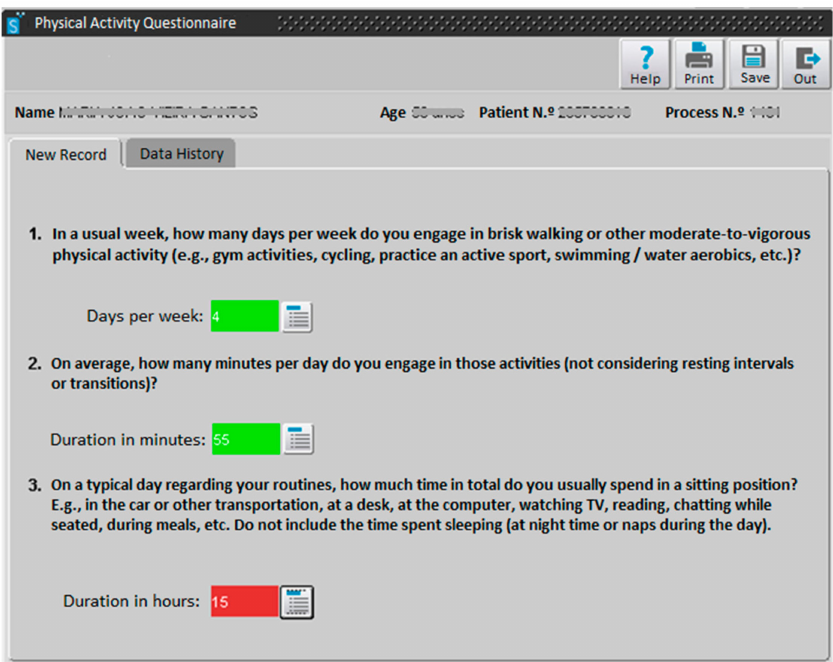
Figure 1. Physical activity brief assessment tool in the database / software “SCl í nico Cuidados de Sa ú